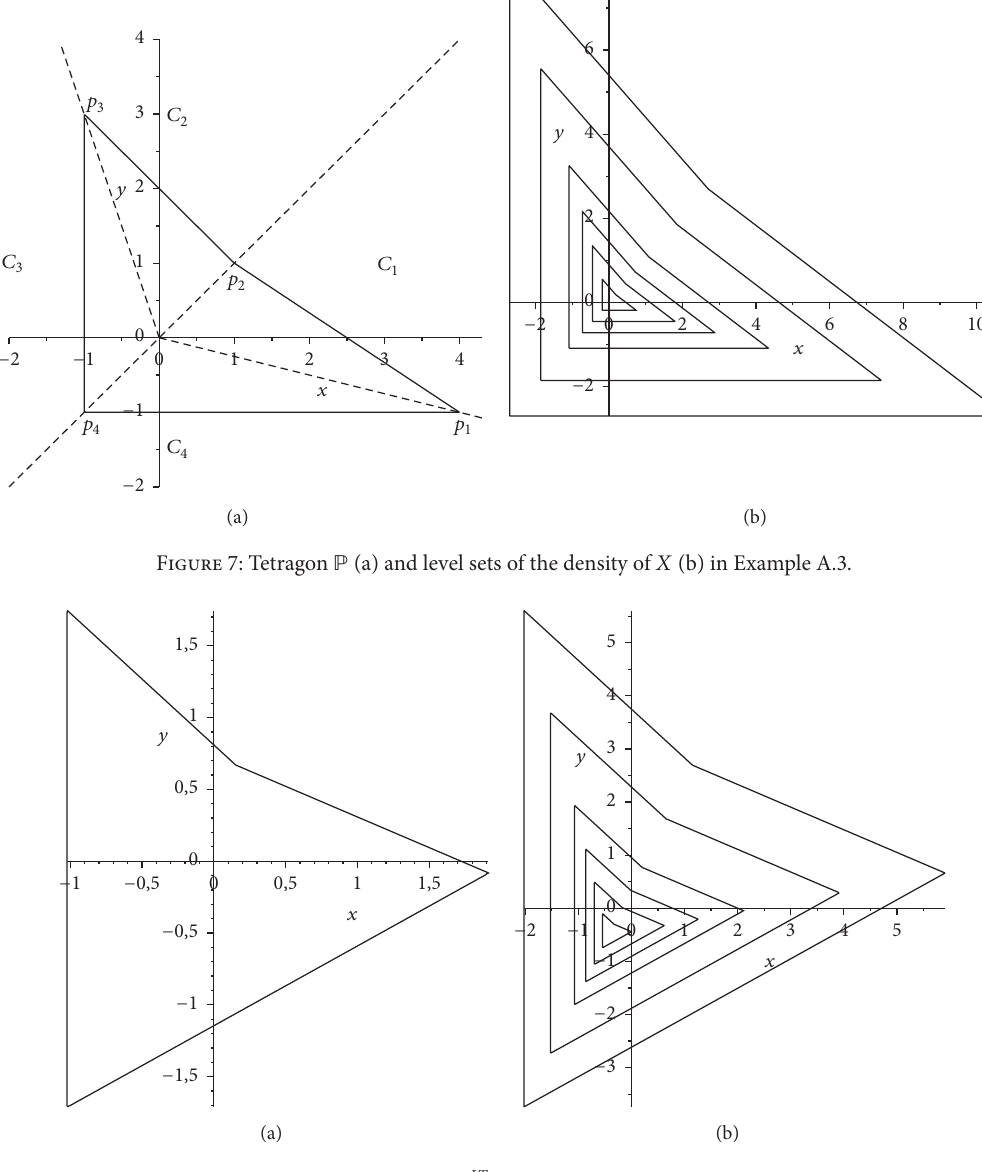
Figure 8: Linear transformed contour defining tetragon P 𝐿𝑇 (a) and density level sets of the density of 𝑌 (b) in Example A.3. Let 𝑞 = (−2, 1.5) and 𝐵 = {𝑥 ∈ ( conv (𝑝 1 , 𝑝 2 ) ∪ conv (𝑝 2 , 𝑝 3 ) ∪ conv (𝑝 3 , 𝑞))}